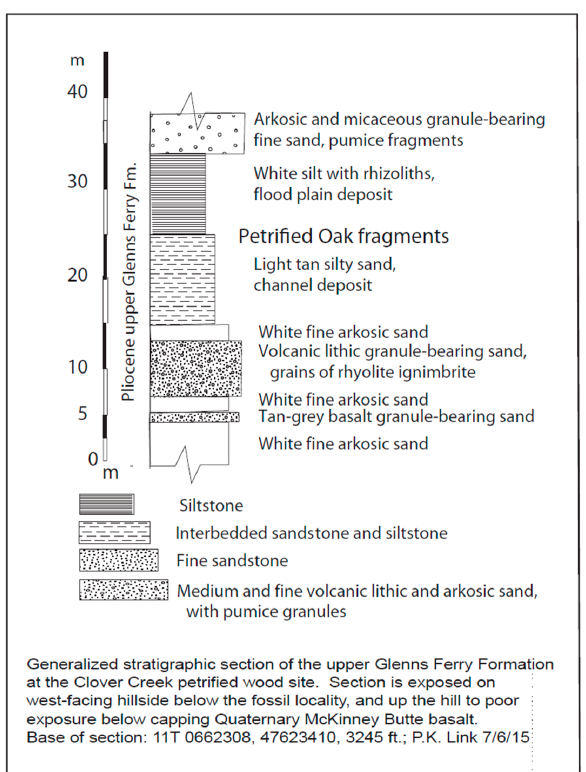
Figure 5. Generalized stratigraphic section of the upper Glenns Ferry Formation at the Clover Creek petrified wood site. Base of the section is in UTM coordinates.